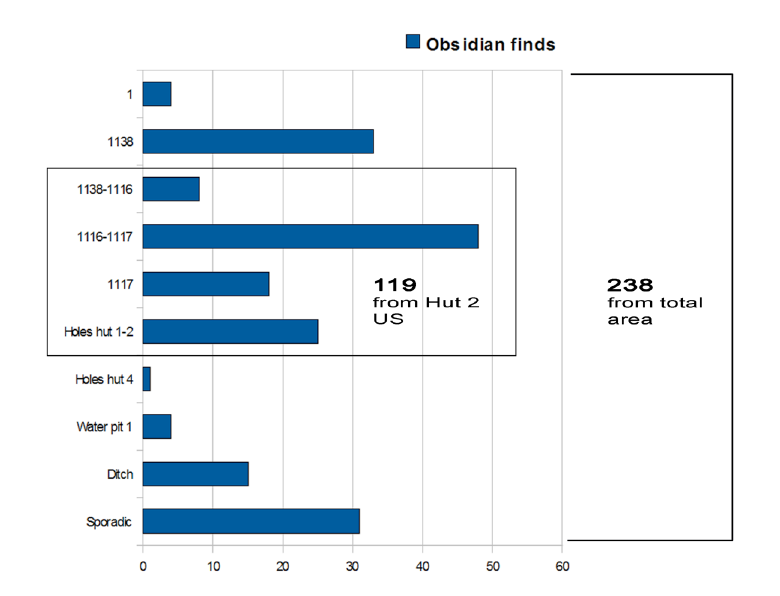
Figure 3. Distribution of obsidian artifacts in the S–F area.